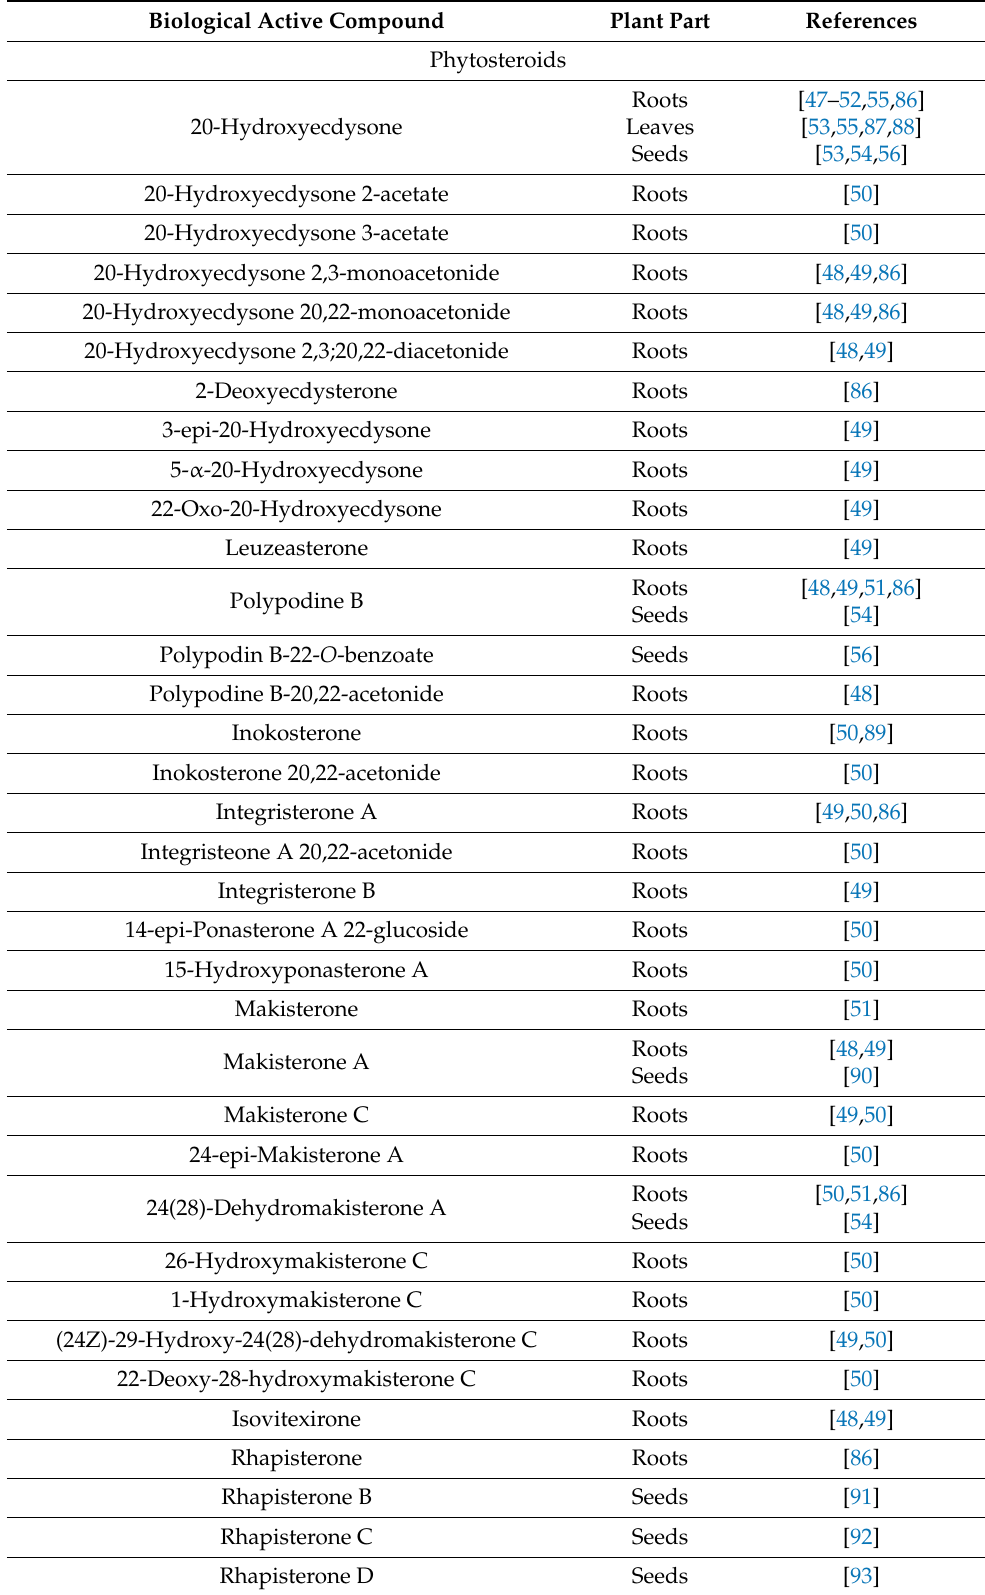
Table 1. Rhaponticum carthamoides bioactive